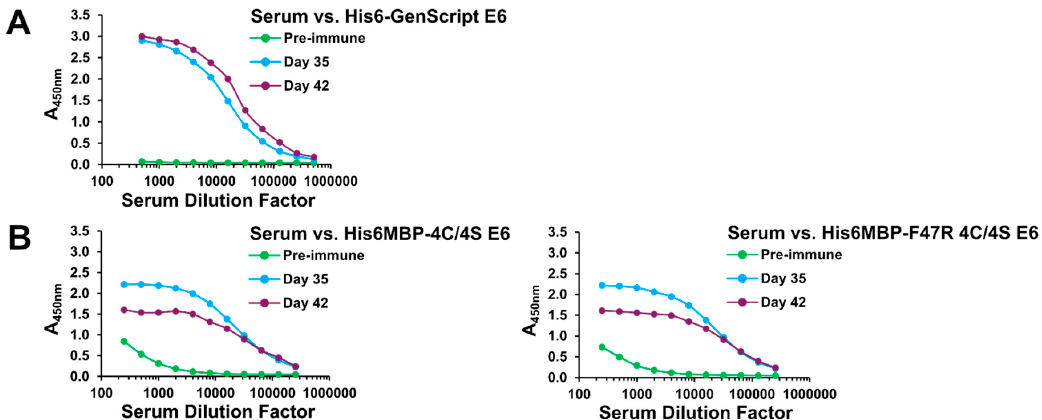
Figure 2. Total serum response following each llama immunization. Following both Immunization #1